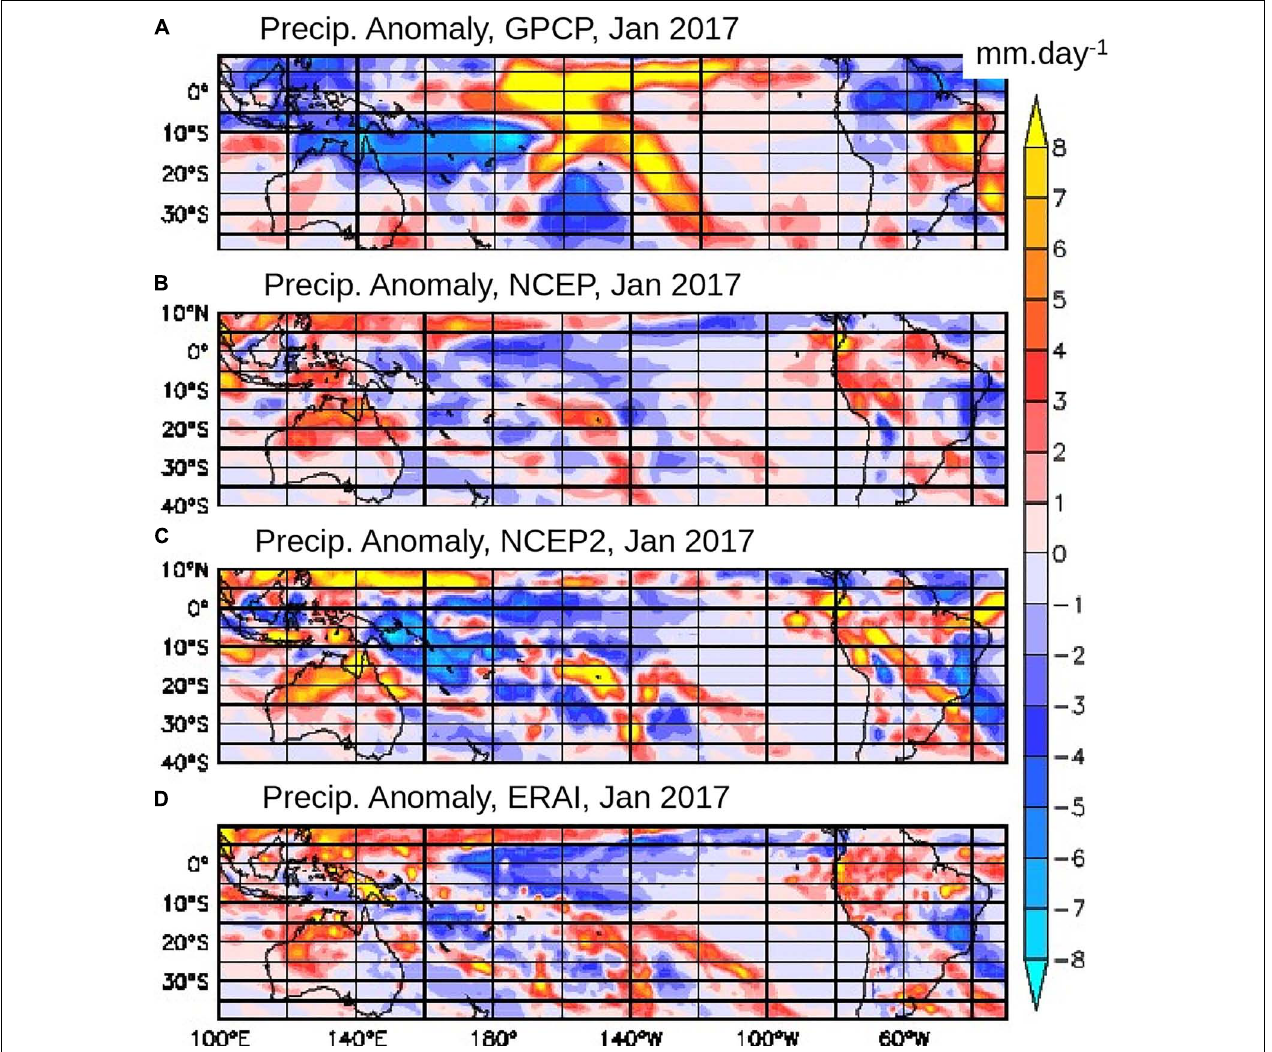
FIGURE 13 | Mean precipitation anomaly (in mm day − 1 ) in January 2017 from: (A) GPCP, (B) NCEP, (C) NCEP2, and (D) ERAI. Monthly anomalies were computed over the period